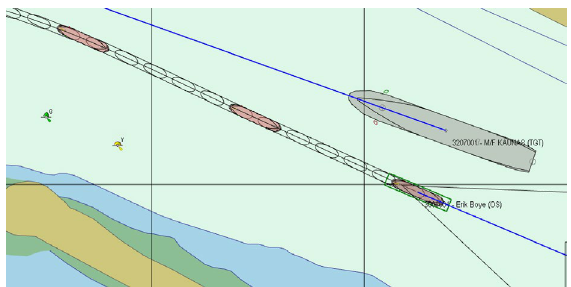
Fig. 6. Scheme for ship sailing in the narrow channel (Ro-Ro and coastal ship)